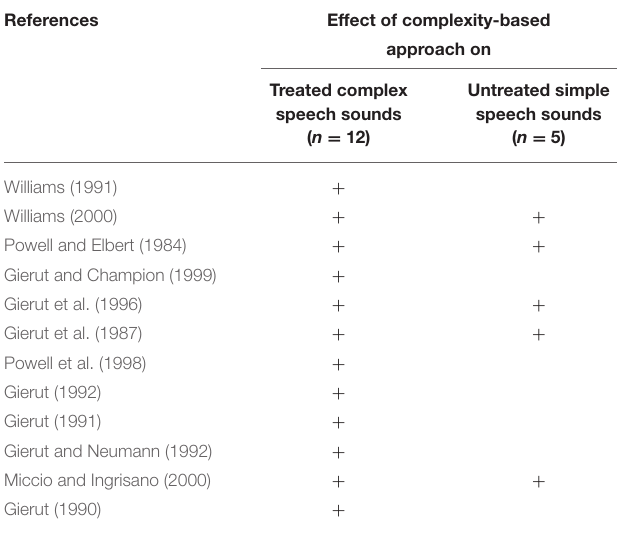
TABLE 2 | Distribution of the included studies across the outcome variables of treated complex speech sounds and untreated simple speech sounds.